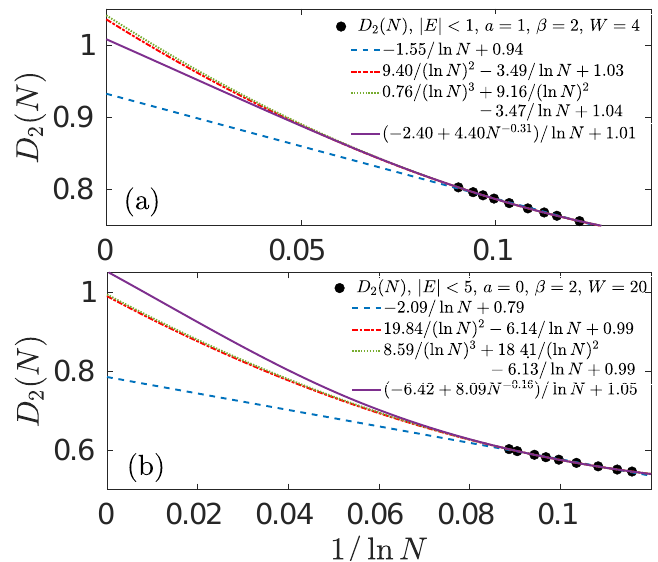
Figure 12: Finite-size extrapolation of the fractal dimension D (symbols) with 2 linear (blue dashed), quadratic (red dash-dotted), cubic (green dotted) expressions in x = 1 / ln L d as well as the one with irrelevant exponent (violet solid) considered in [ 34 ] . We show two parameter sets (upper panel) a = 1, β = 2 is W = 4 and (lower panel) a = 0, β = 2 is W = 20 in order to emphasize that this issue present both at weak and strong disorder. D is averaged over the energy interval | E | < W / 4 2 and extrapolated from L = 75, 85, 100, 125, 150, 175, 200, and 250 with the corre- sponding number of disorder realizations 2000, 2000, 2000, 2000, 1000, 600, 600, and 300,